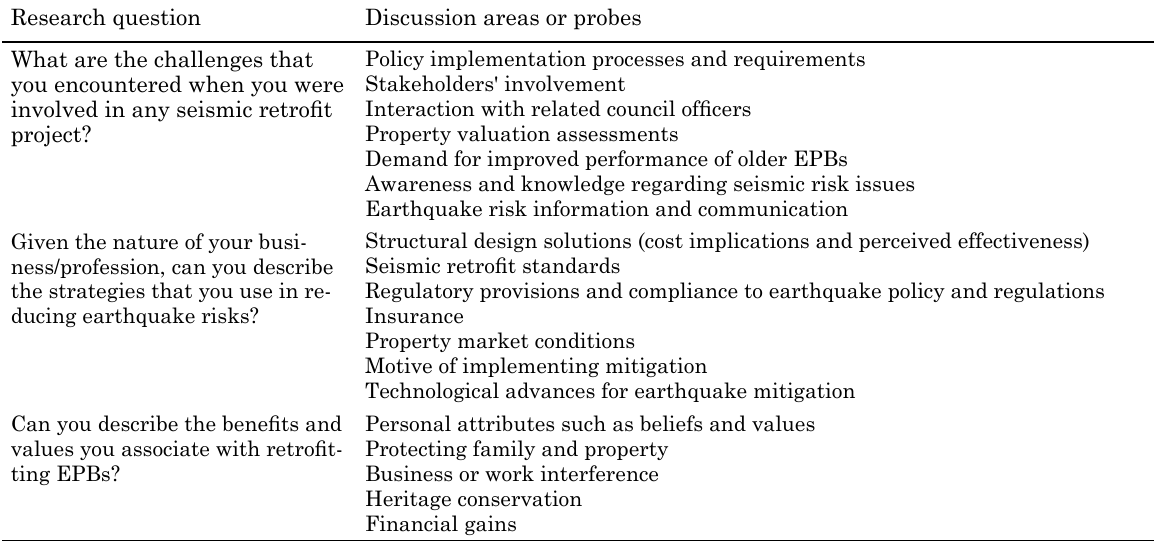
Table A1. Interview protocol by research